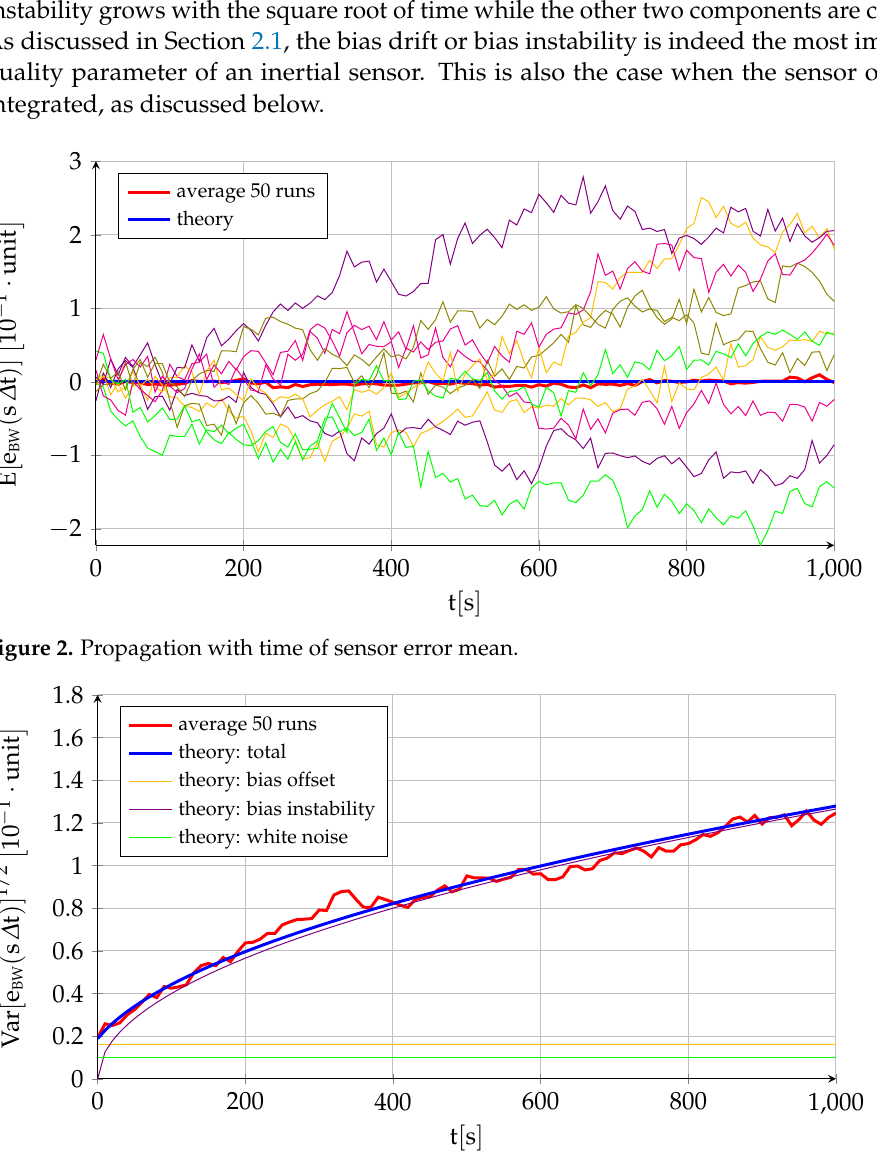
Figure 3. Propagation with time of sensor error standard